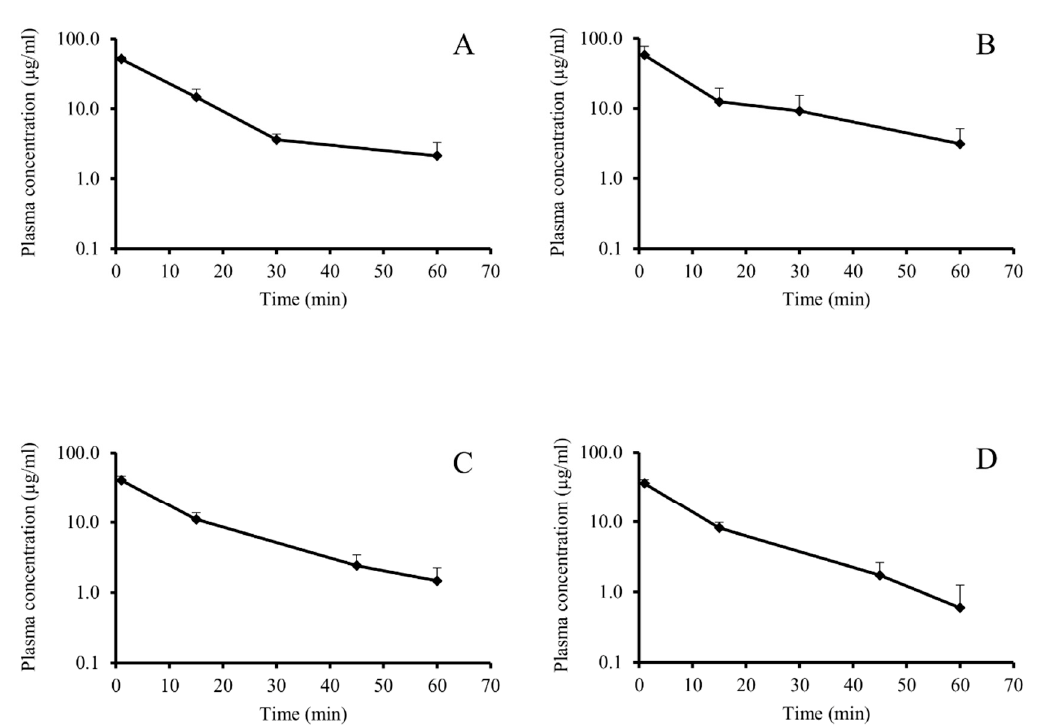
Group F: pharmacokinetic parameters followed the two-compartment, first-order kinetic model. Group NF: pharmacokinetic parameters did not follow the two-compartment, first-order kinetic model. V d : Volume of distribution at 1 min. CL: clearance. nd: k c values in Group NF could not be determined.